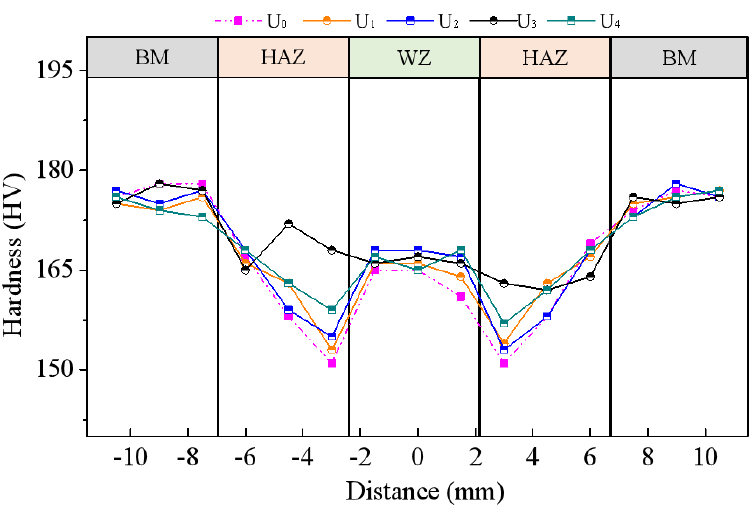
Figure 12. Microhardness distribution in a welded joint.